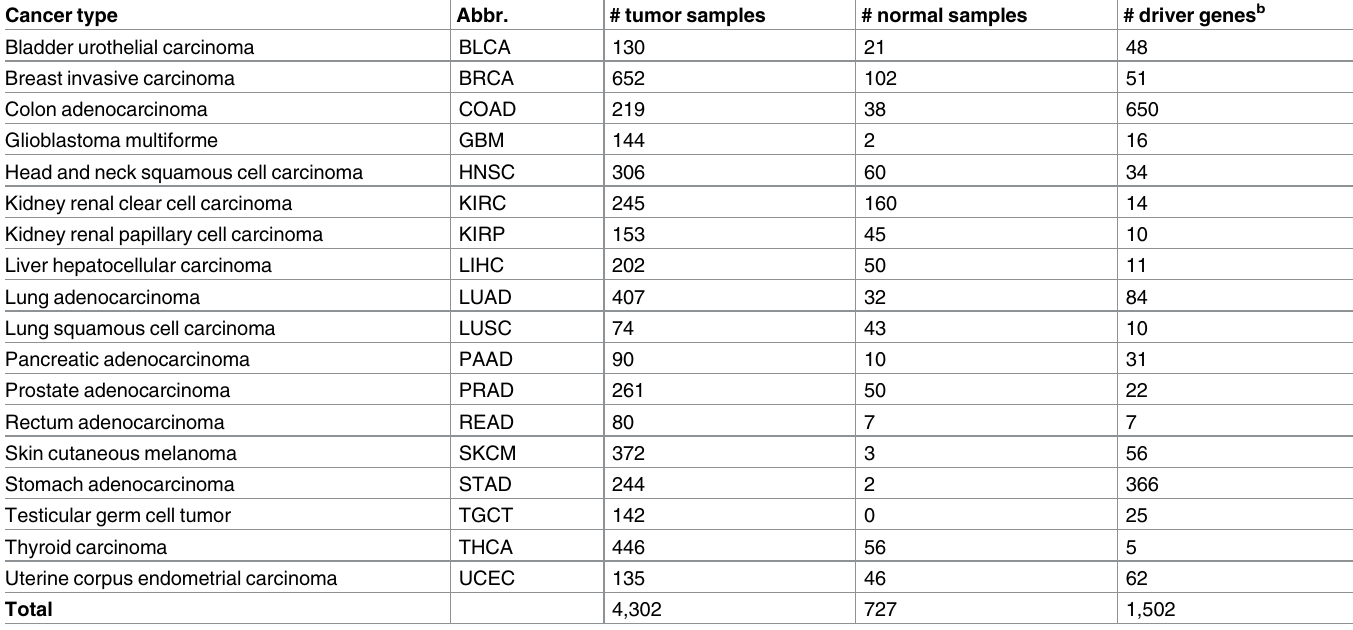
Table 1. Number of tumor samples, normal samples a , and driver genes across 18 cancer types. Cancer type Abbr. # tumor samples # normal samples # driver genes